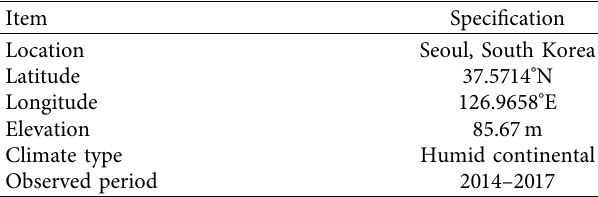
Table 1: Station